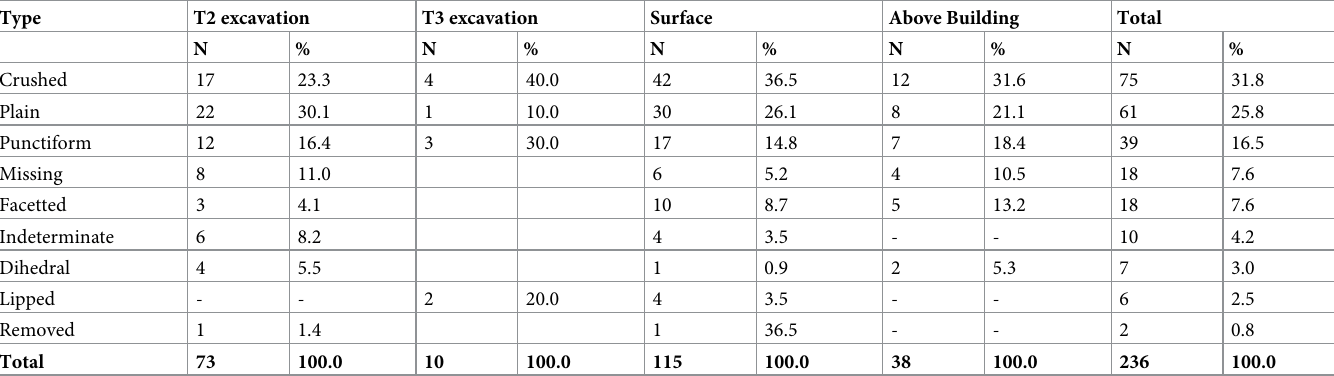
Table 13. Striking platforms of flint thinning flakes by assemblage.